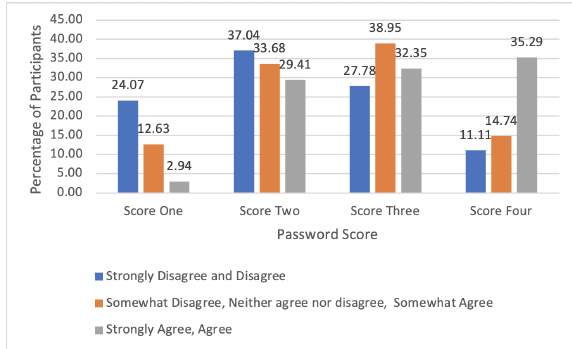
Figure 14. Responses about password security behavior practices in relation to zxcvbn password